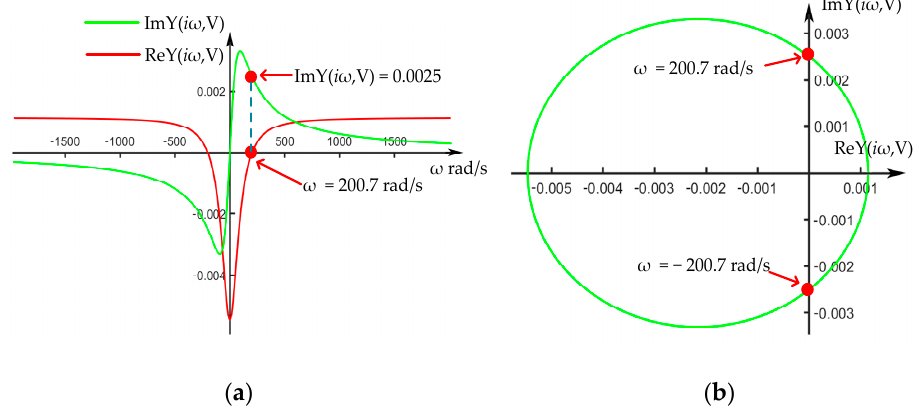
Figure 7. ( a ) Small-signal frequency response of memristor and ( b ) Nyquist diagram of memristor when it operates under V = 0.1031 V, x = − 1.022, L * = 1.972 H. Table 2. Properties of locally active regions.